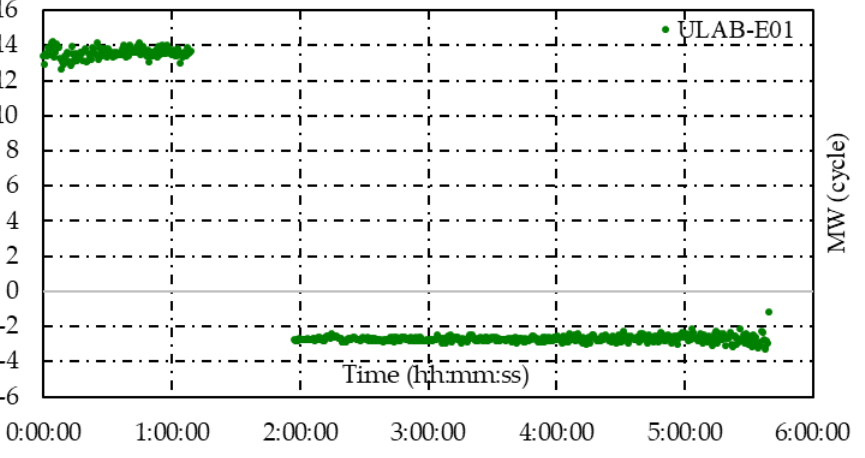
Figure 6. Original MW arc of E01 for site ULAB.